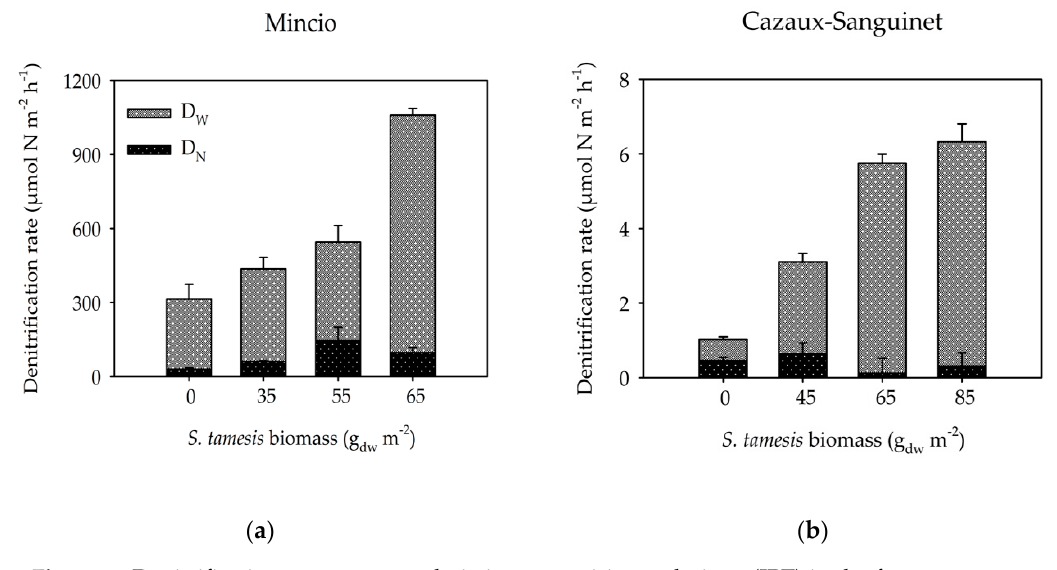
Figure 2. Denitrification rates measured via isotope pairing technique (IPT) in the four treatments in the Mincio River ( a ) and in the Cazaux-Sanguinet Lake ( b ). D W represents the denitrification of NO 3 − diffusing to anoxic sediments from the water column, whereas D N is the denitrification of NO 3 − produced by nitrification in the sediment. Averages ± standard errors are reported. Note different scales on y -axis.